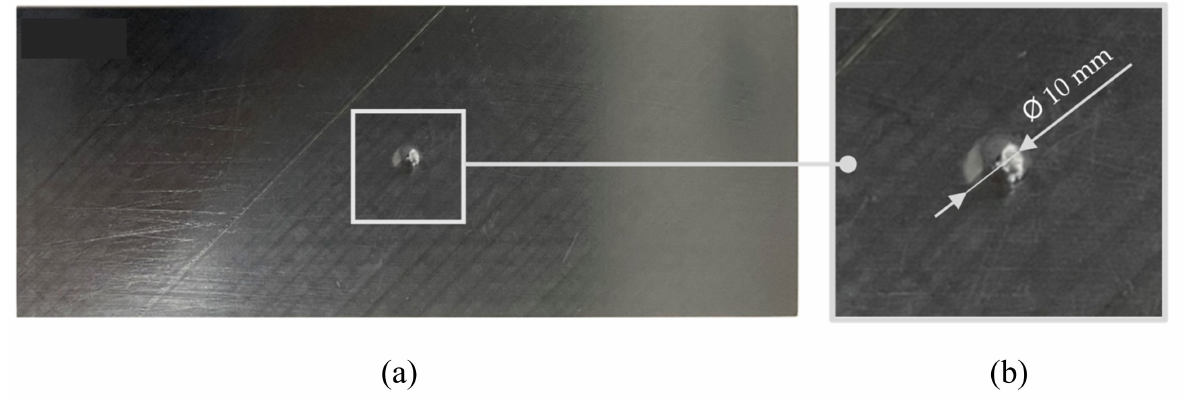
Figure 7. Specimen after impact E = 10 J; Overall specimen view ( a ); Detailed view ( b ).